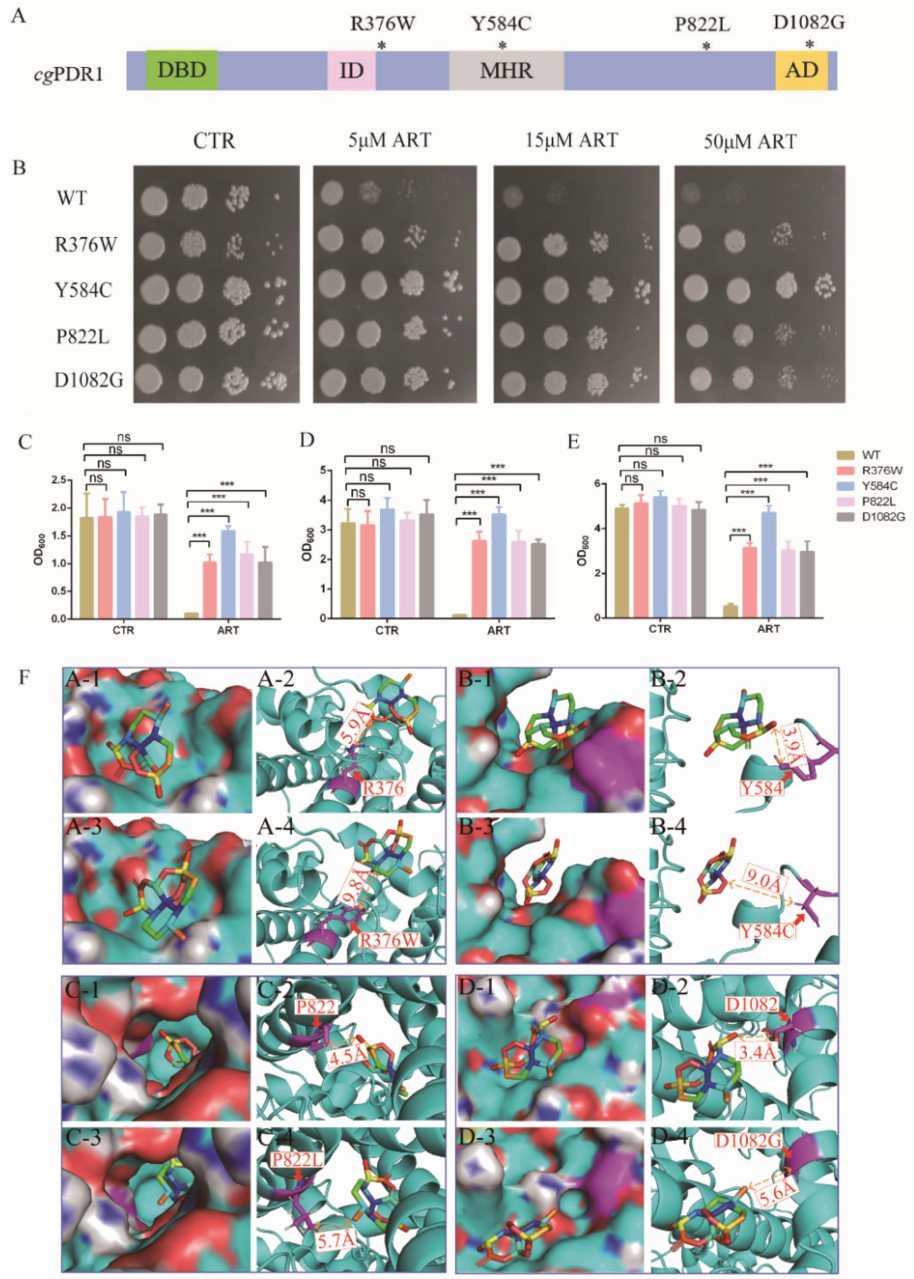
Figure 3. Artemisinin targets transcription factor PDR1. ( A ) Schematic showing CgPDR1 putative functional domains and mutation sites. * means the location of mutation sites; DBD, DNA-binding domain; ID, inhibitory domain; MHR, middle homology region; AD, activation domain. ( B ) PDR1 mutant strains were resistant to artemisinin by spot assay. Four dots mean 10-fold serial dilutions of yeast cells. PDR1 mutations were resistant to artemisinin in liquid medium after a 9 h incubation ( C ), 18 h incubation ( D ) and 27 h incubation ( E ). Data are mean ± SD of three independent experiments. Data were analyzed by GraphPad Prism. *** p -value < 0.0005; ns means no significant change. ( F ) Three-dimensional structure showing the action of artemisinin on wild-type or mutant